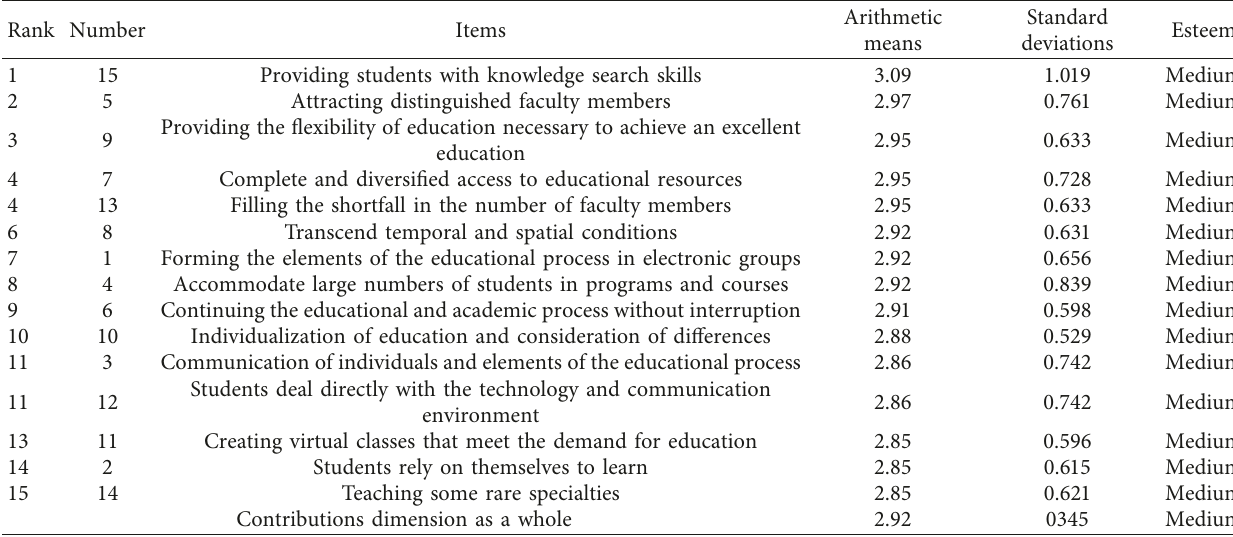
Table 7: Averages and standard deviations of proposed methods to overcome distance education hurdles during university crises, sorted descendingly Rank